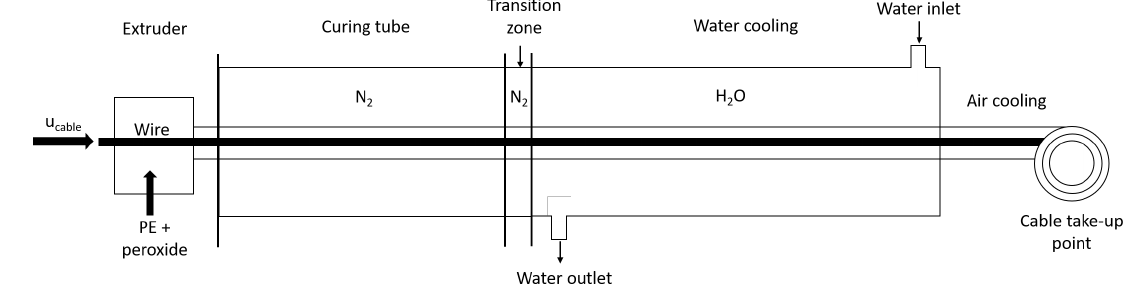
Figure 2. Schematic of power cable production